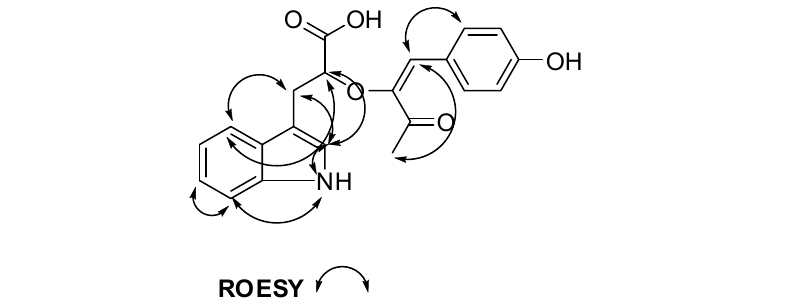
Figure 4. Key ROESY correlations (double arrows) provide further confirmation of the structure of compound 1 . Table 1. 1D and 2D-NMR spectroscopic data for compound ( 1 ) in DMSO- d 6 , in ppm.